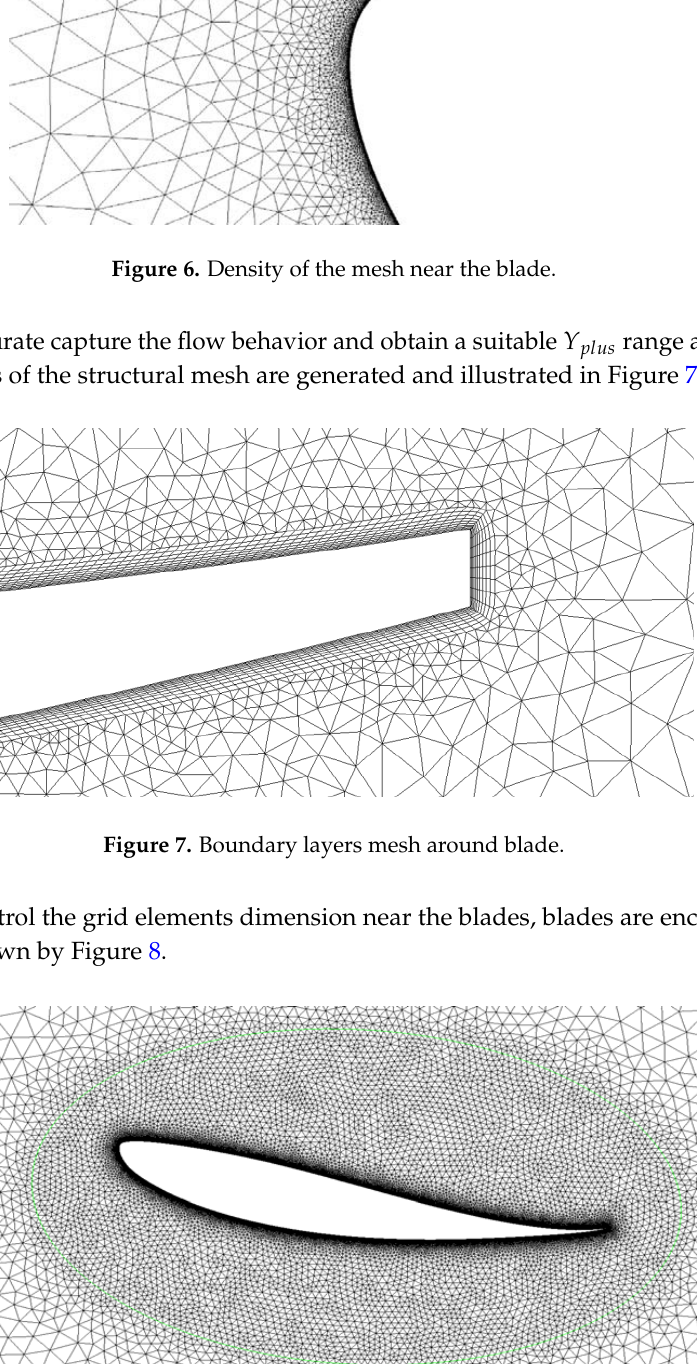
Figure 8. Control ellipse.